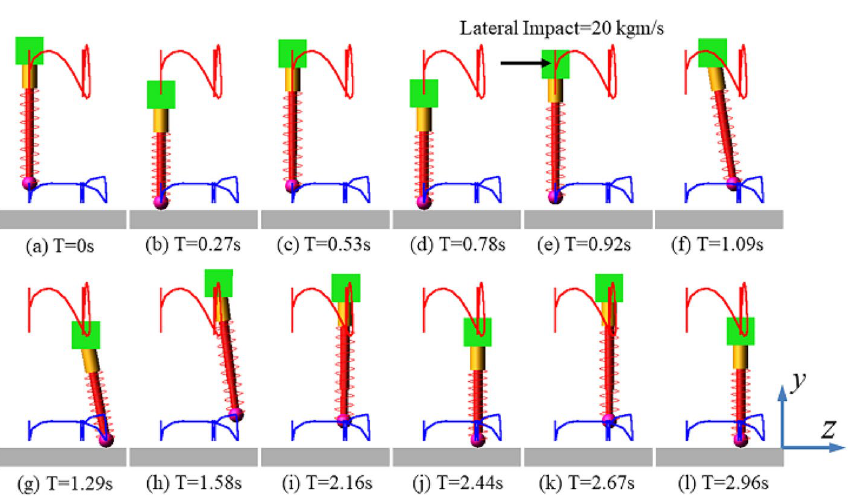
Figure 11. Motion sequence diagram for vertically jumping SLIP system under the lateral